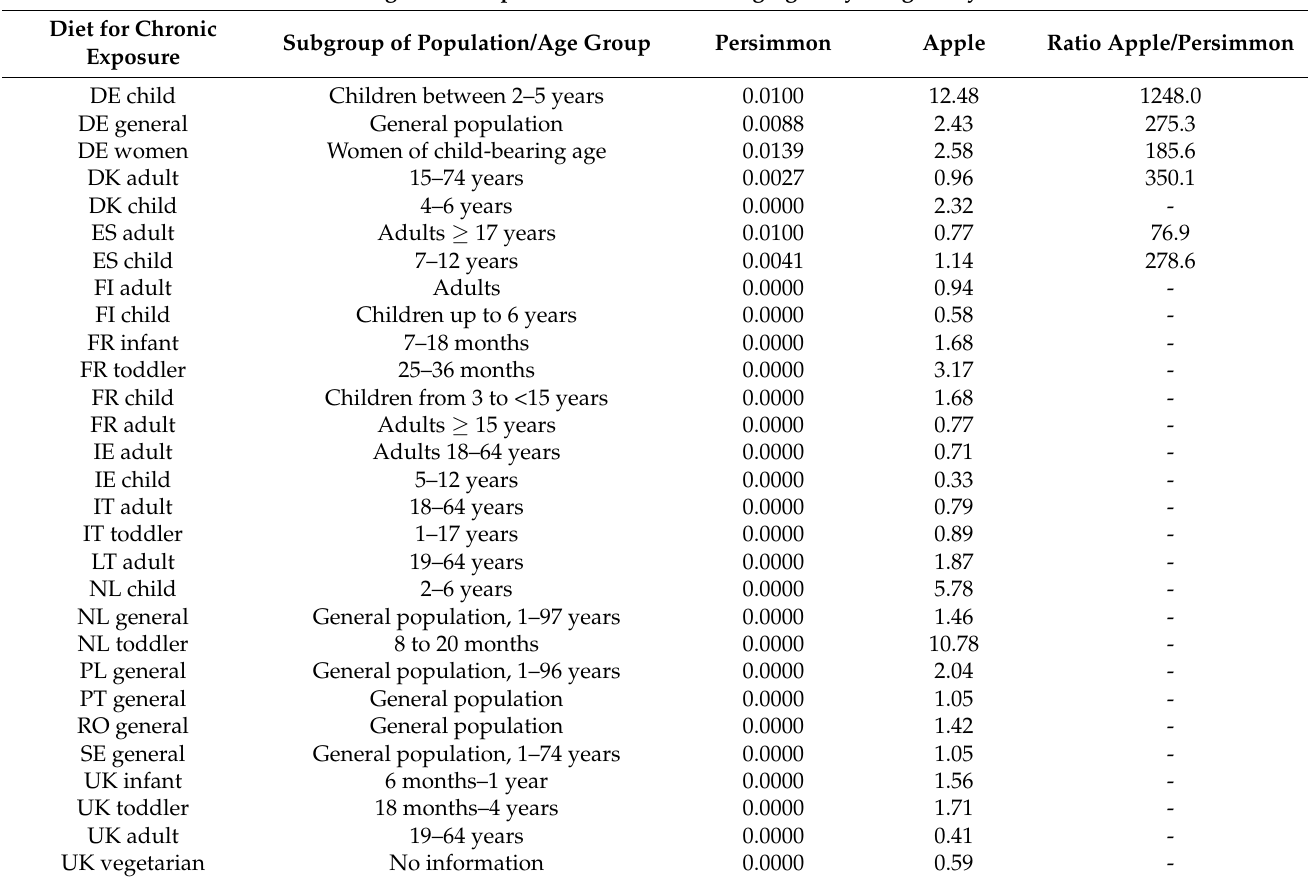
Table 7. Comparison of the average consumption data-food intake (g/kg body weight/day) apple- persimmon for the EU Member